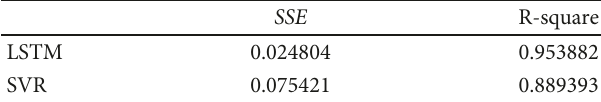
Table 1: Evaluation index calculation